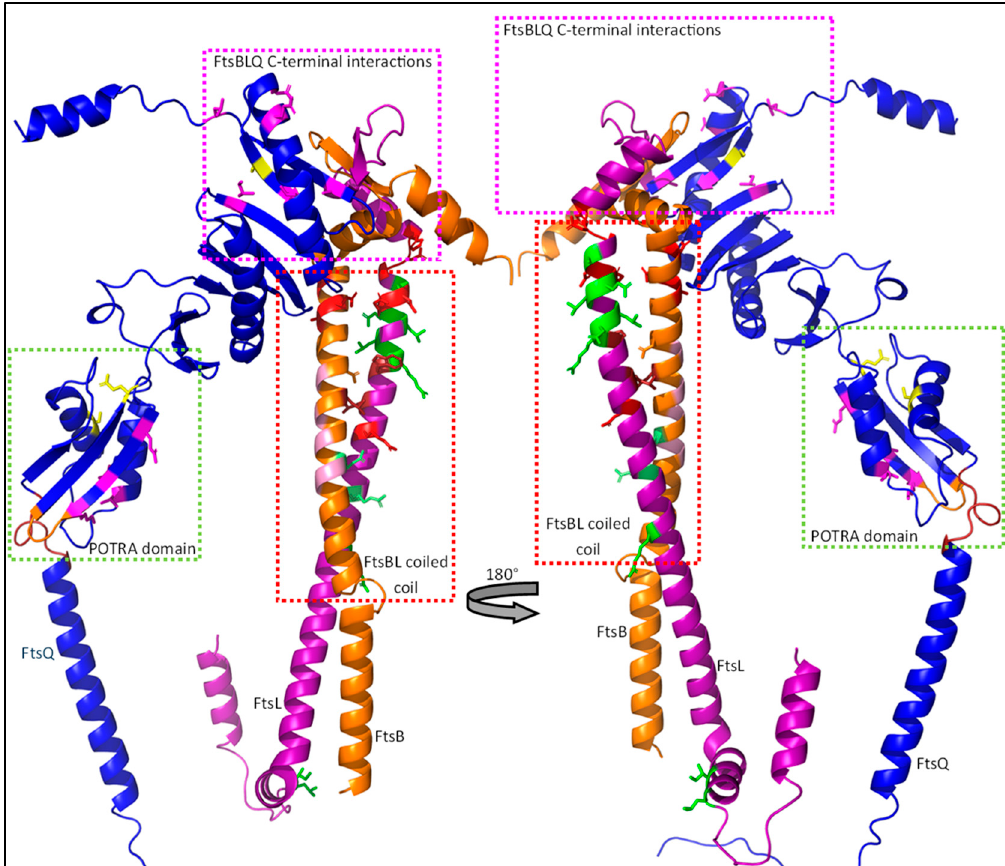
Figure 10. The FtsBLQ regulatory subcomplex. Shown is the FtsBLQ subcomplex responsible for the regulation of the septal peptidoglycan synthesis machinery. The largest subunit, FtsQ, acts as a scaffold and comprises a small cytosolic domain, a transmembrane domain, and a large periplasmic domain. FtsB and FtsL have a similar structure, mostly consisting of a long helical structure, and form a coiled coil together. FtsB has a short cytoplasmic tail, while FtsL carries a large cytosolic double helical structure involved in the recruitment of FtsW. Regions or interactions that are important for sPG synthesis regulation are highlighted by the colored boxes and are further detailed in Figure 11 (POTRA domain), Figure 13 (FtsBL coiled coil) and Figure 15 (FtsBLQ C-terminal interactions). The structures shown here are predictions produced with AlphaFold2, advanced and visualized with the PyMOL Molecular Graphics System, Version 2.5.2 Schrödinger, LLC. Sequences for the prediction were obtained from the UniProtKB database (P06136-1 for FtsQ, Q9HXZ6-1 for FtsB and P0AEN4- for